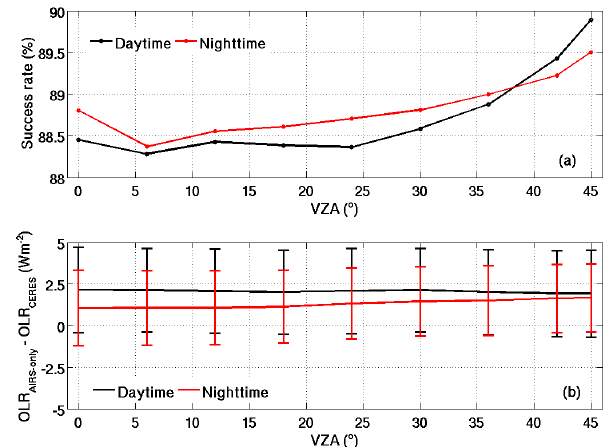
Figure 6. (a) and (b) are similar to Fig. 4c and d but for the AIRS footprints classified as clear sky by the algorithm in this study, while their collocated CERES footprints are identified as cloudy sky. Mean ± standard deviation of the difference (OLR AIRS-only – OLR CERES ) is also given on the plot.